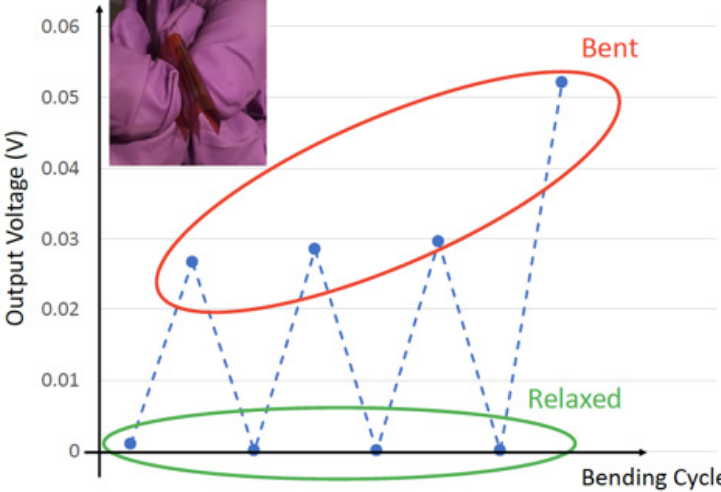
Figure 8. Bending experiment and the produced output voltage.